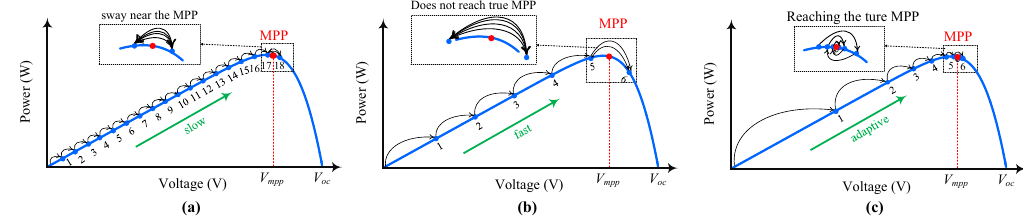
Figure 10. Illustration of the step size impact on the conversion: ( a ) small step; ( b ) big step; ( c ) adaptive